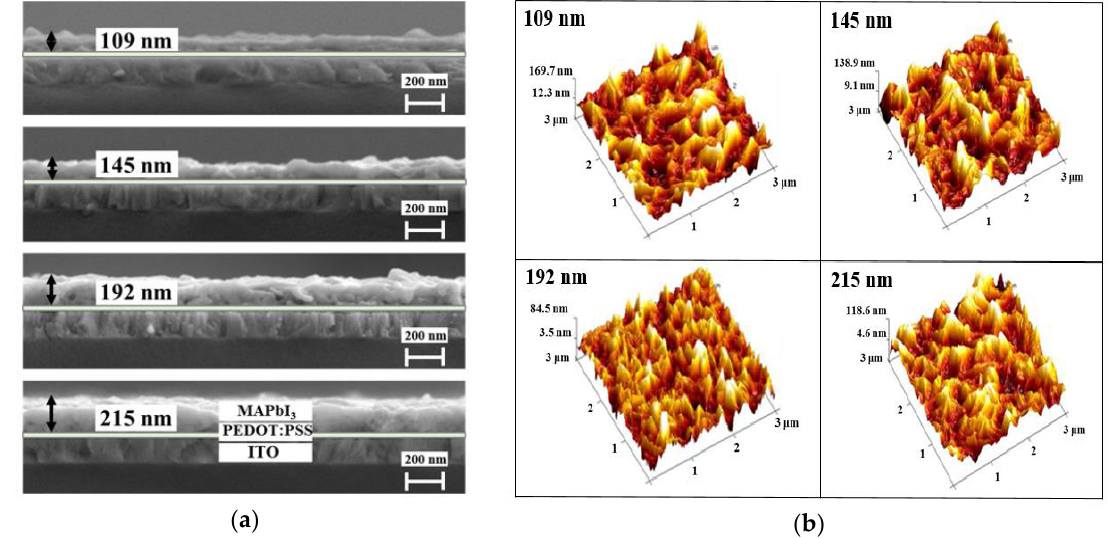
Figure 6. ( a ) Cross-sectional SEM images and ( b ) AFM images of MAPbI 3 layer with different thicknesses at an annealing temperature 100 °C.